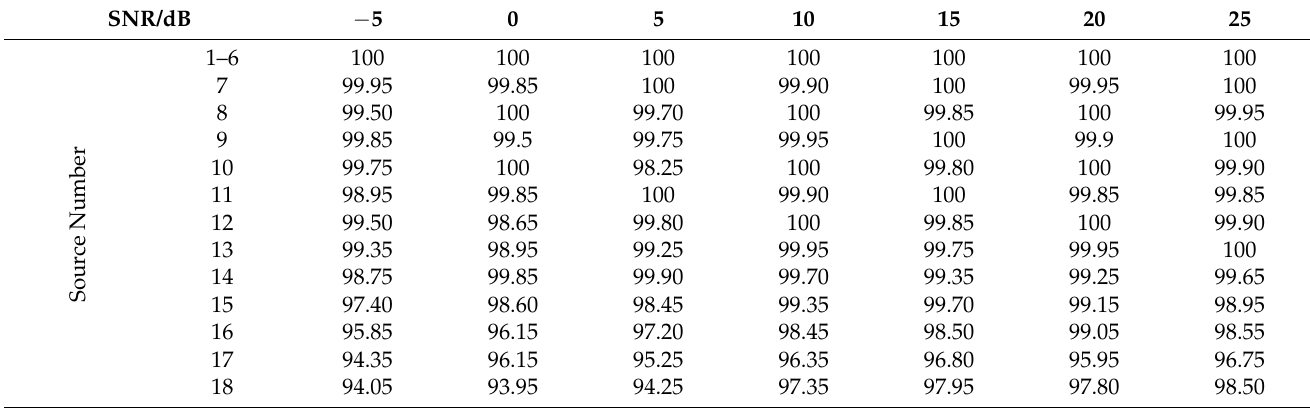
Table 4. Consistency rates of ULA source number estimation at different SNRs.